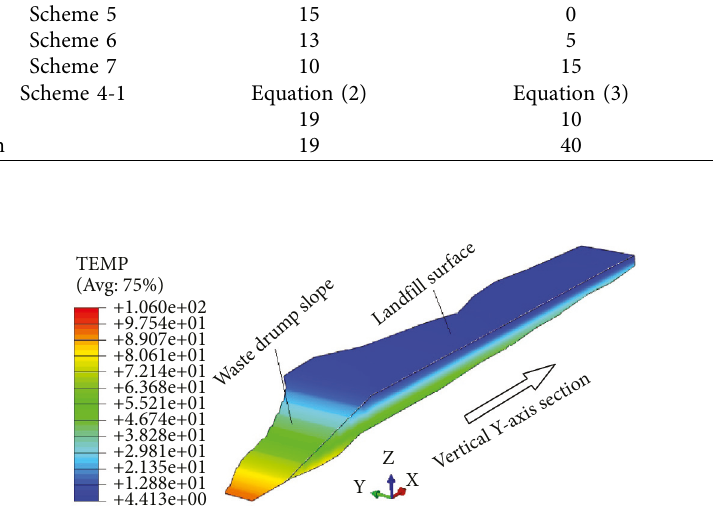
Figure 7: Simulated cloud chart of buried depth in Scheme 4-1 (m).